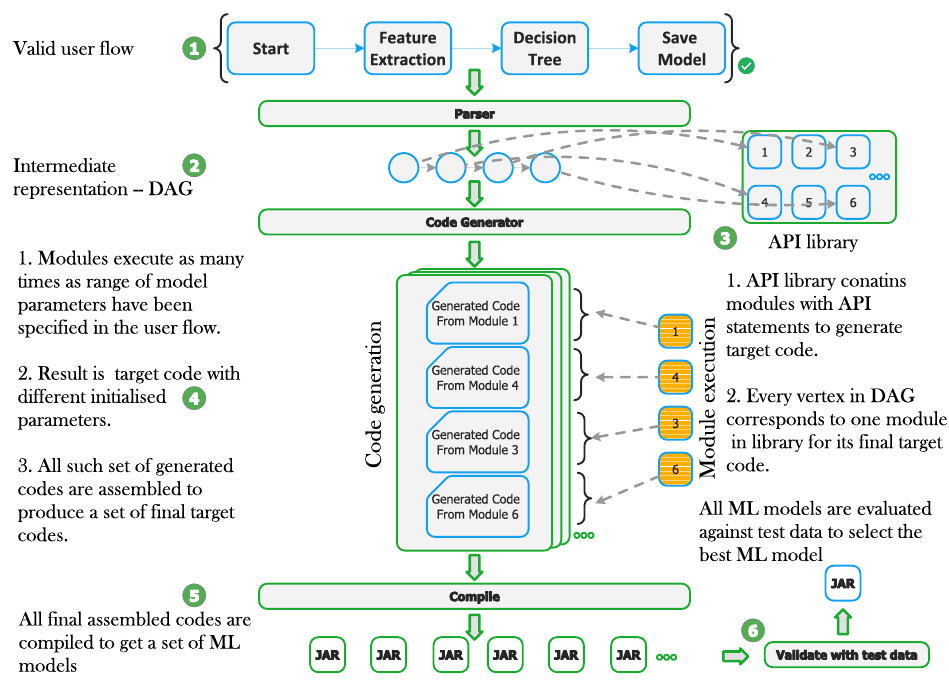
Figure 3. Generation of an ML model from a graphical user